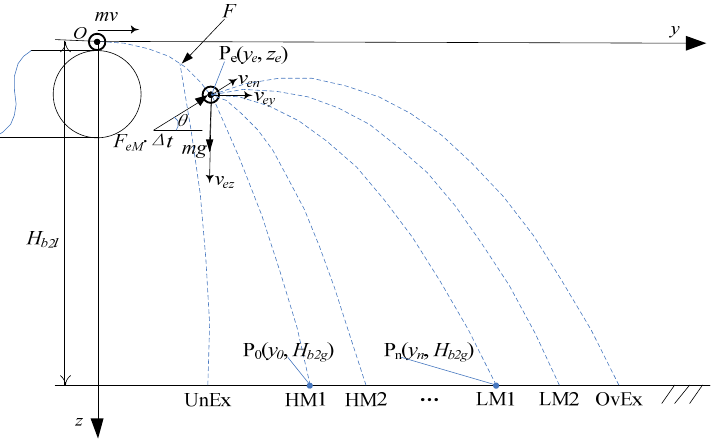
Figure 6. Schematic diagram of falling point control by separation of variable gas-ejection. Position synchronization and variable action on a range of materials during